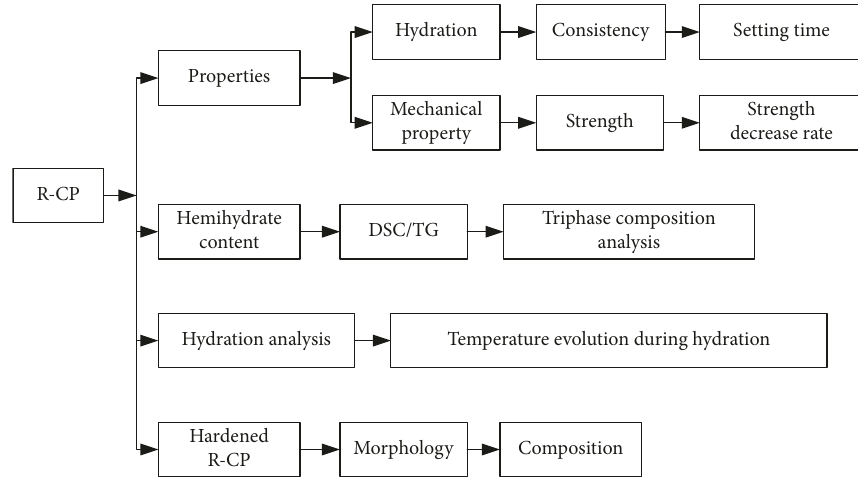
Figure 4: The experimental program of